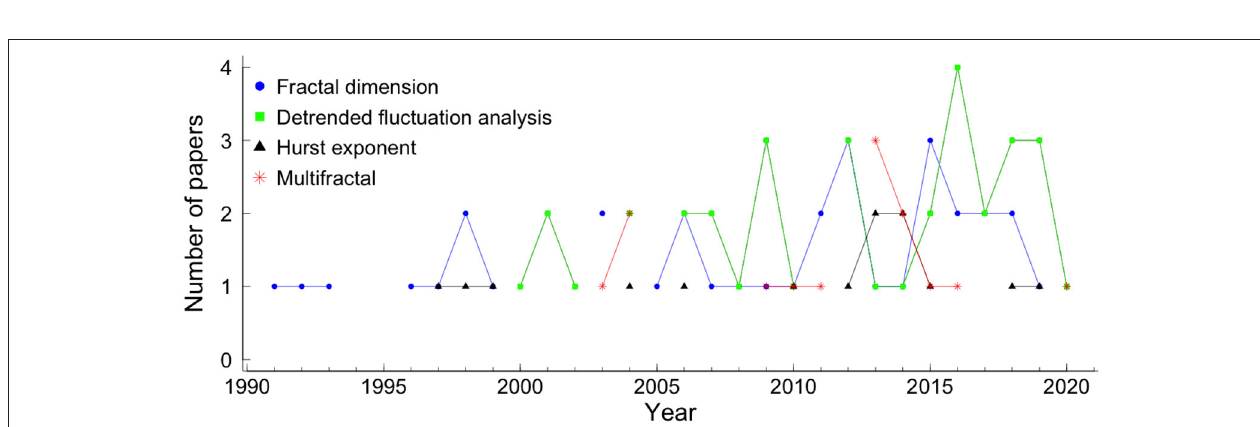
FIGURE 4 | Papers using compression in fetal heart rate, by year. The red circle represents the Lempel-Ziv compressor and the blue square represents the other compressors.